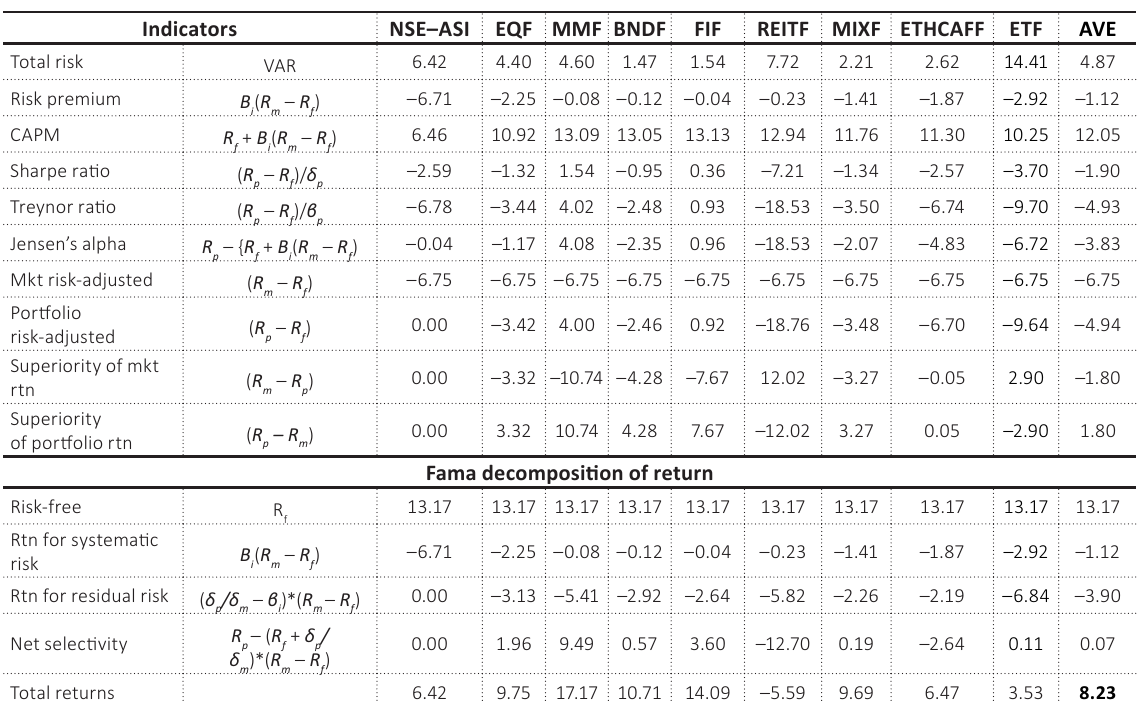
Table 3. Risk-adjusted performance of the schemes in Nigeria (January 2016 – May